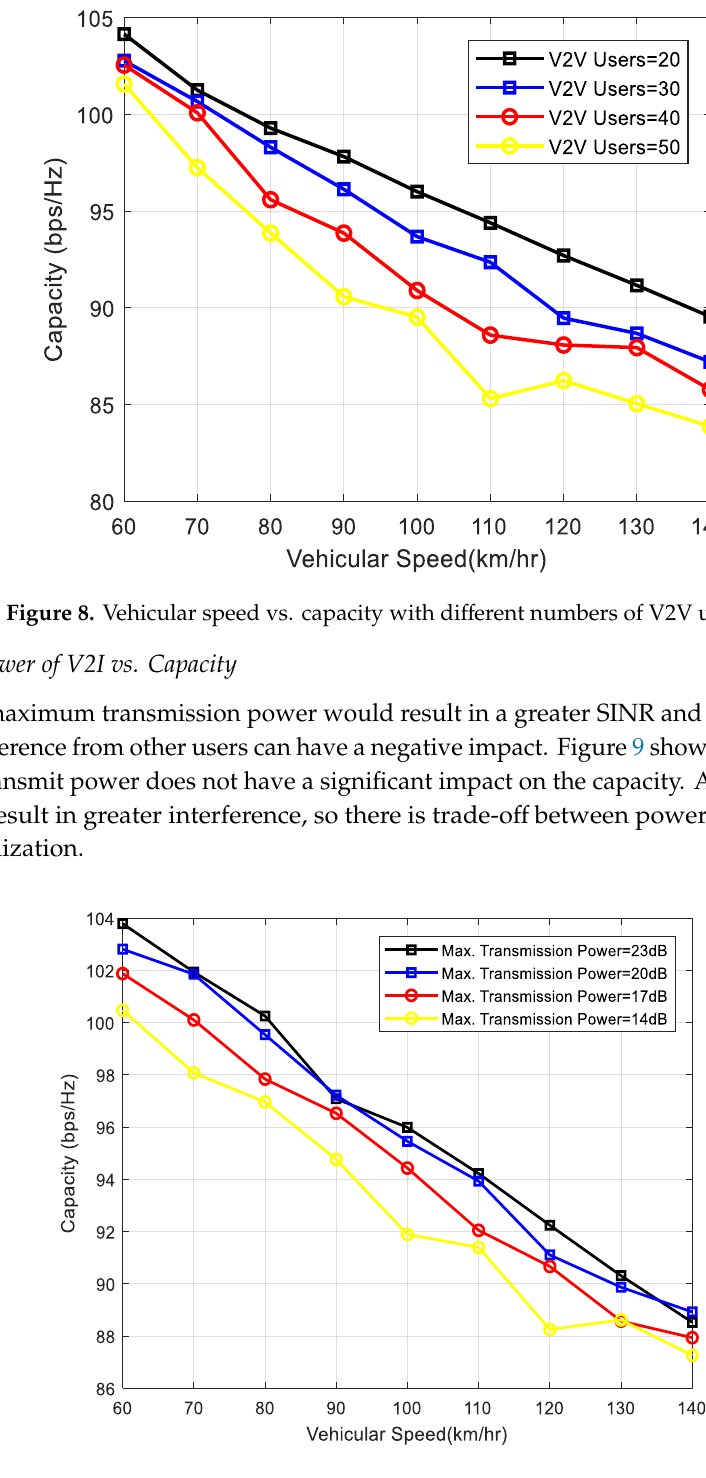
Figure 9. Vehicular speed vs capacity at different transmission powers.